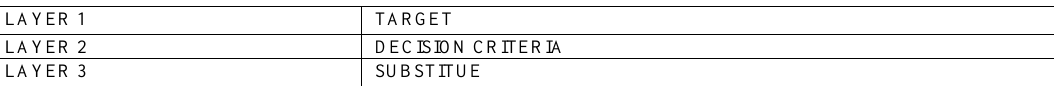
Table1. Resource allocation scheme –Systematic Ladder Process